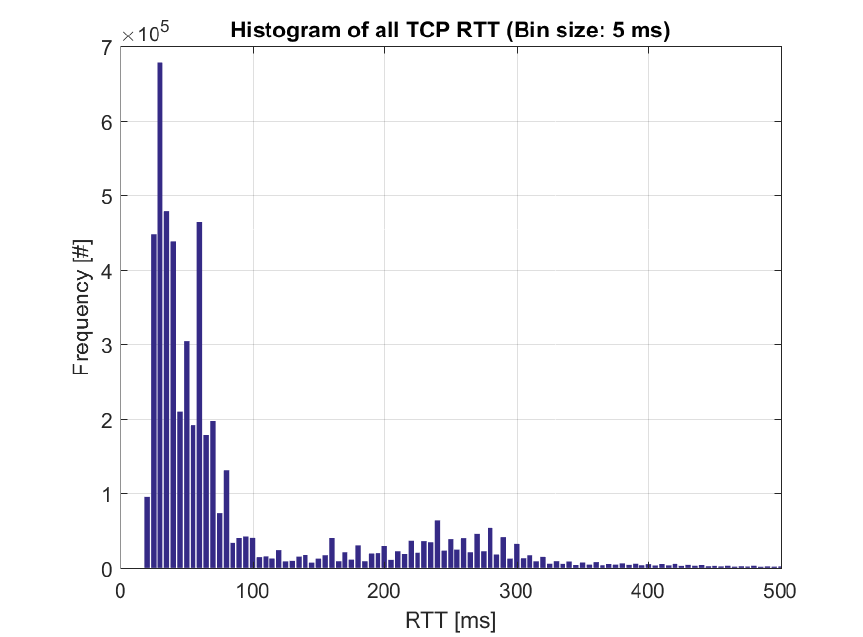
Figure 8. Distribution of TCP-RTT traces based on real measurements via NetMap